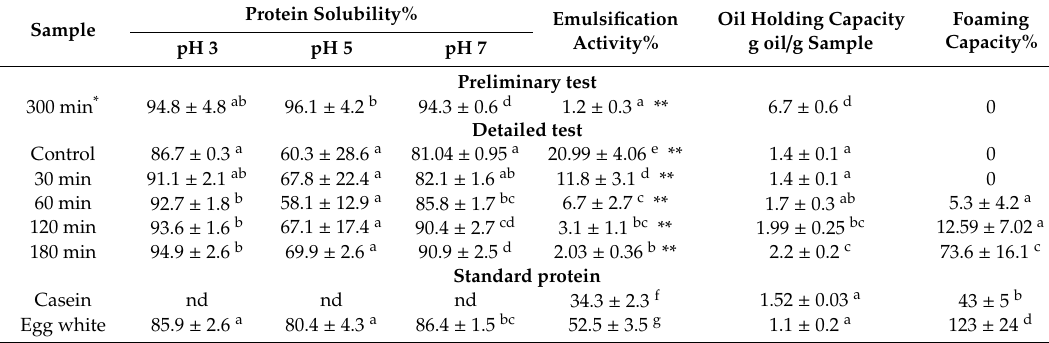
Table 2. Techno-functional properties of freeze-dried samples collected at di ff erent time: protein solubility (pH 3, 5, 7), emulsification ability, oil holding and foaming capacity. Information about casein and egg white functionality are also